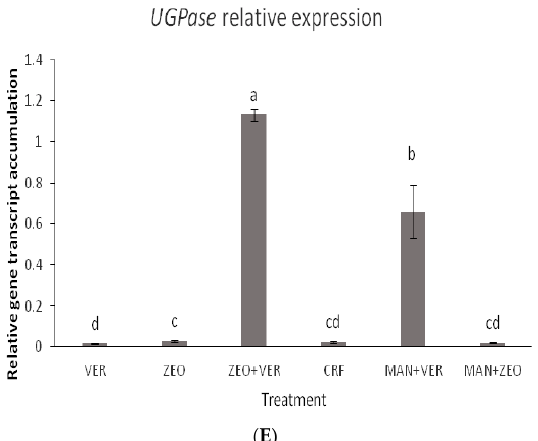
Figure 6. Relative gene transcript accumulation for KC1 ( A ), SW2 ( B ), N3 ( C ), SPS ( D ) and UGPase ( E ) among the treatments. The different letters on the bars signify statistically significant differences among the treatments, according to Duncan’s multiple range test, for p ≤ 0.05. VER: vermiculite; ZEO: zeolite; CRF: controlled-release fertilizer; MAN: manure.